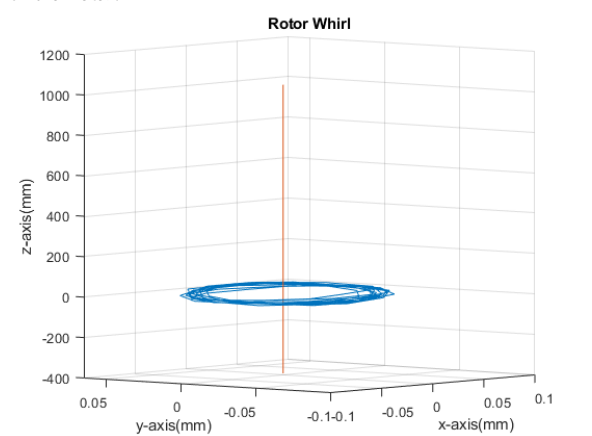
Figure 12. Vibration trajectories at extracted